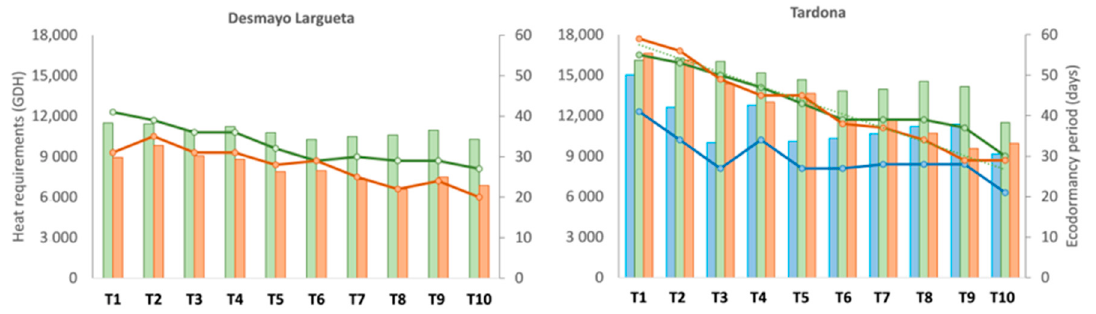
Figure 3. Heat requirements (bars) and the ecodormancy period (lines) during Season 1 (blue), Season 2 (green) and Season 3 (orange). Desmayo Largueta data of Season 1 were missing. Season 2